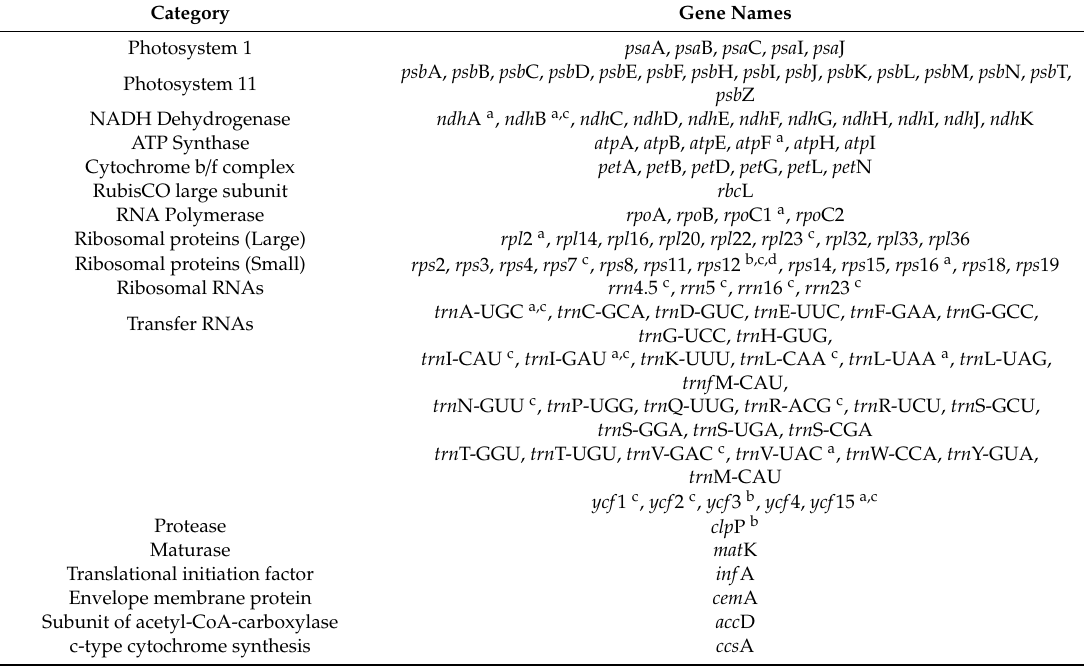
Table 2. Genes present in the chloroplast genomes of five Str. ionanthus